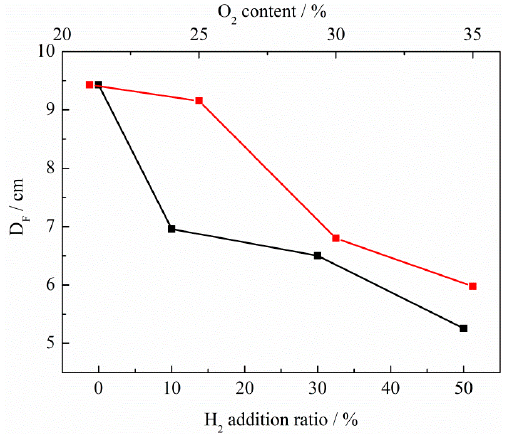
Figure 11. Flame thickness along the centerline at various H 2 addition ratios ( black line ) and O 2 enrichment levels ( red line ).